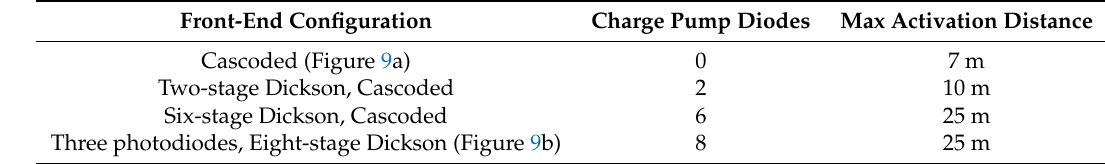
Figure 9. Prototypes of the laser-based zero standby solution. ( a ) The cascoded solution used for a 48 V DC power over Ethernet (PoE) fan. This prototype uses a simple latching/unlatching scheme consisting of a 15 k Ω resistor, diode, 2 V Zener diode, and button. ( b ) The Dickson charge pump solution used for a battery-powered lamp. The footer switch is latched via a microcontroller, and unlatched with a coded IR signal. This prototype uses an array of three photodiodes. ( c ) The transmitter pulses a 5 mW laser pointer with a 1 kHz waveform generated by a microcontroller. Table 4. Maximum activation distance of various prototype